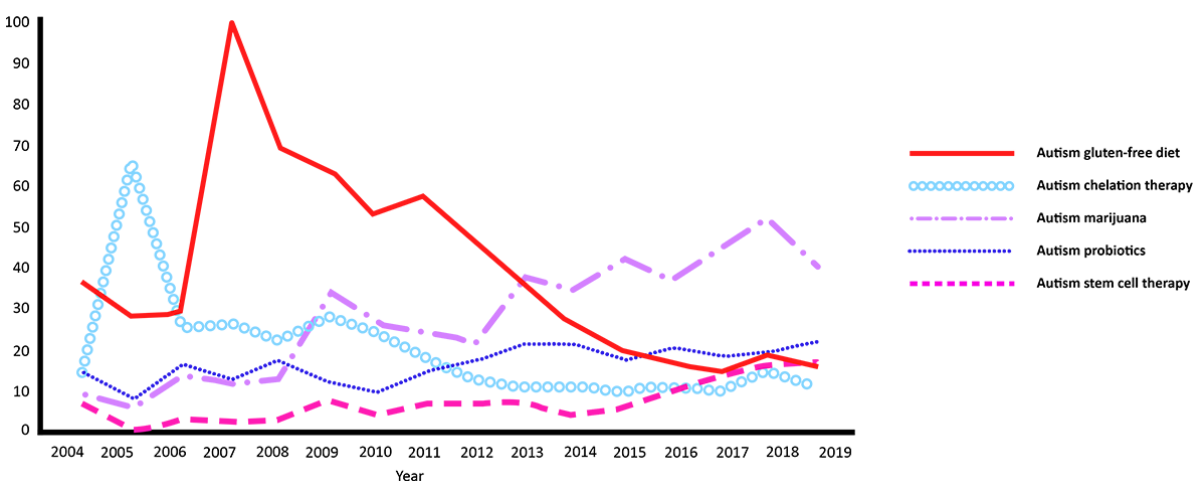
Figure 3. Google Trends analyses for web searches related to queries about interventions for autism in the United States from 2004 to